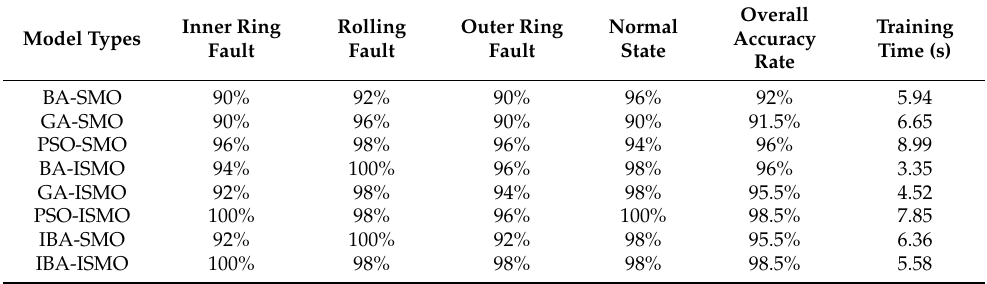
Figure 12. IBA-ISMO Model verification. Table 4. Model recognition results.